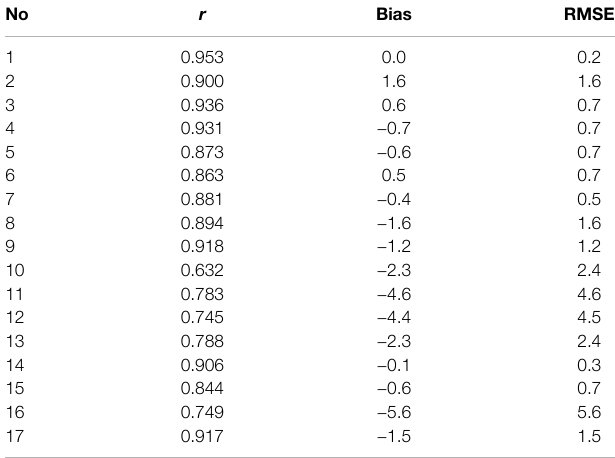
TABLE 4 | Comparison of ERA5-Land annual mean temperature with observations at all 17 stations.